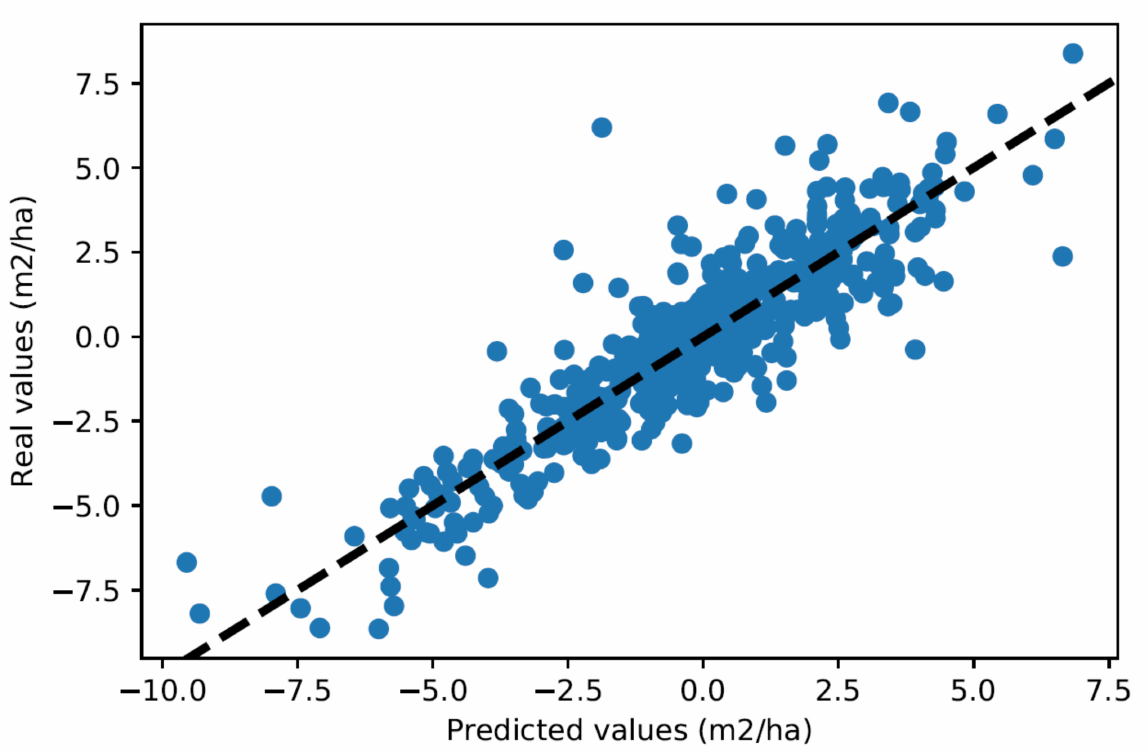
Figure 16. Residuals plot for ∆ G predictions at the level of couples (division, inventory year) for the large woods